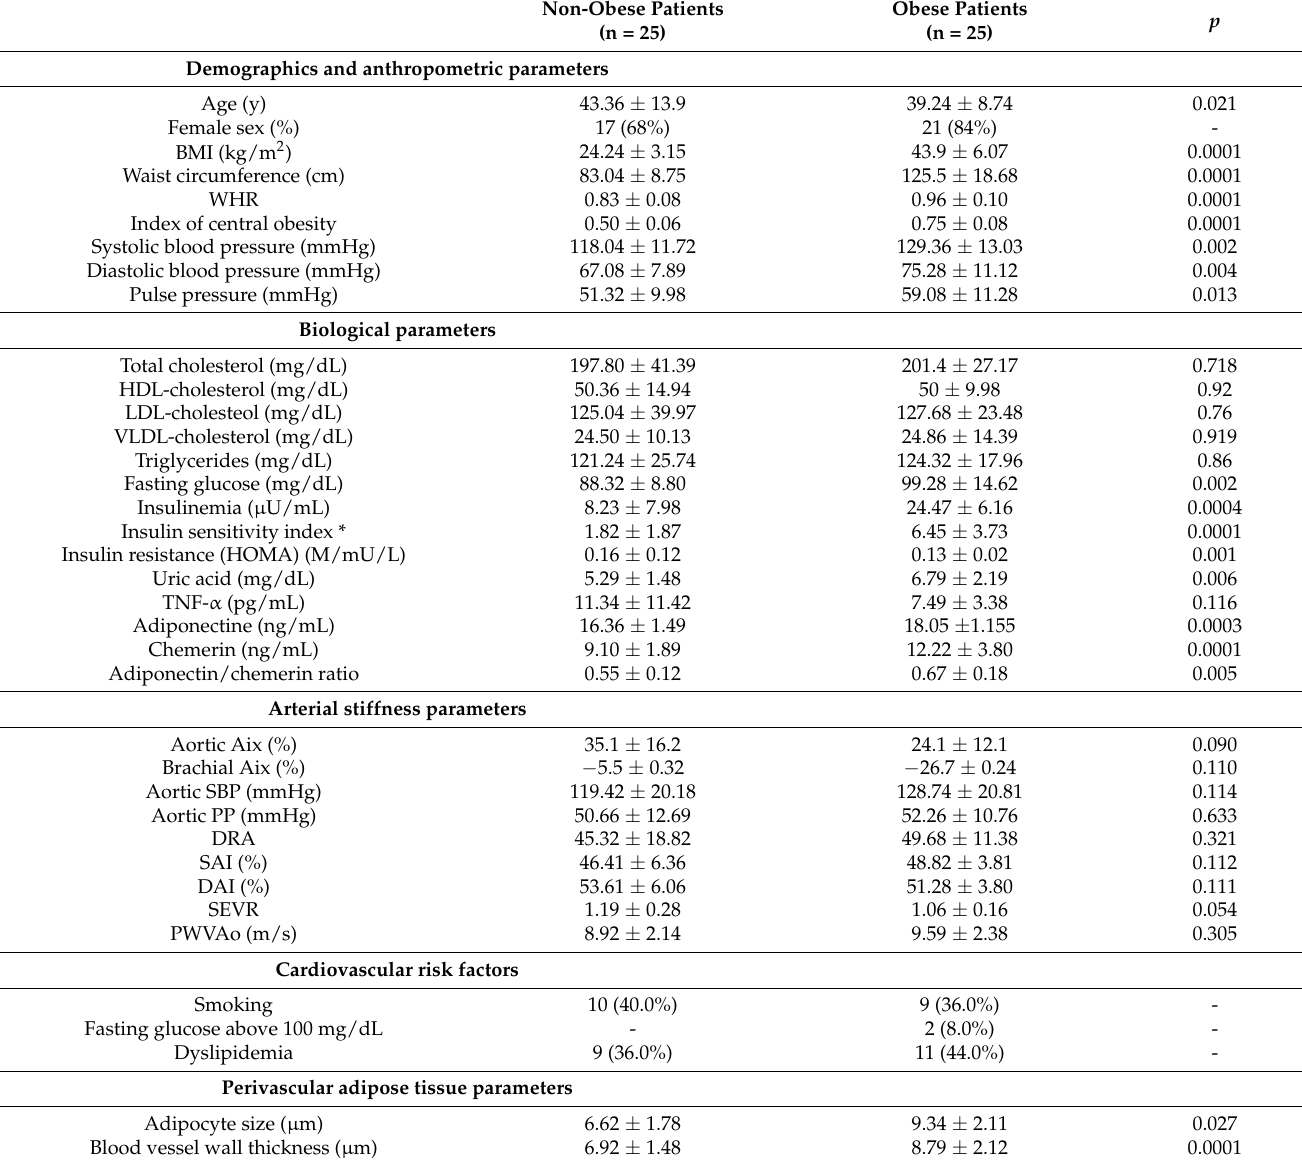
Table 1. Demographics, anthropometric and paraclinical parameters in the two studied